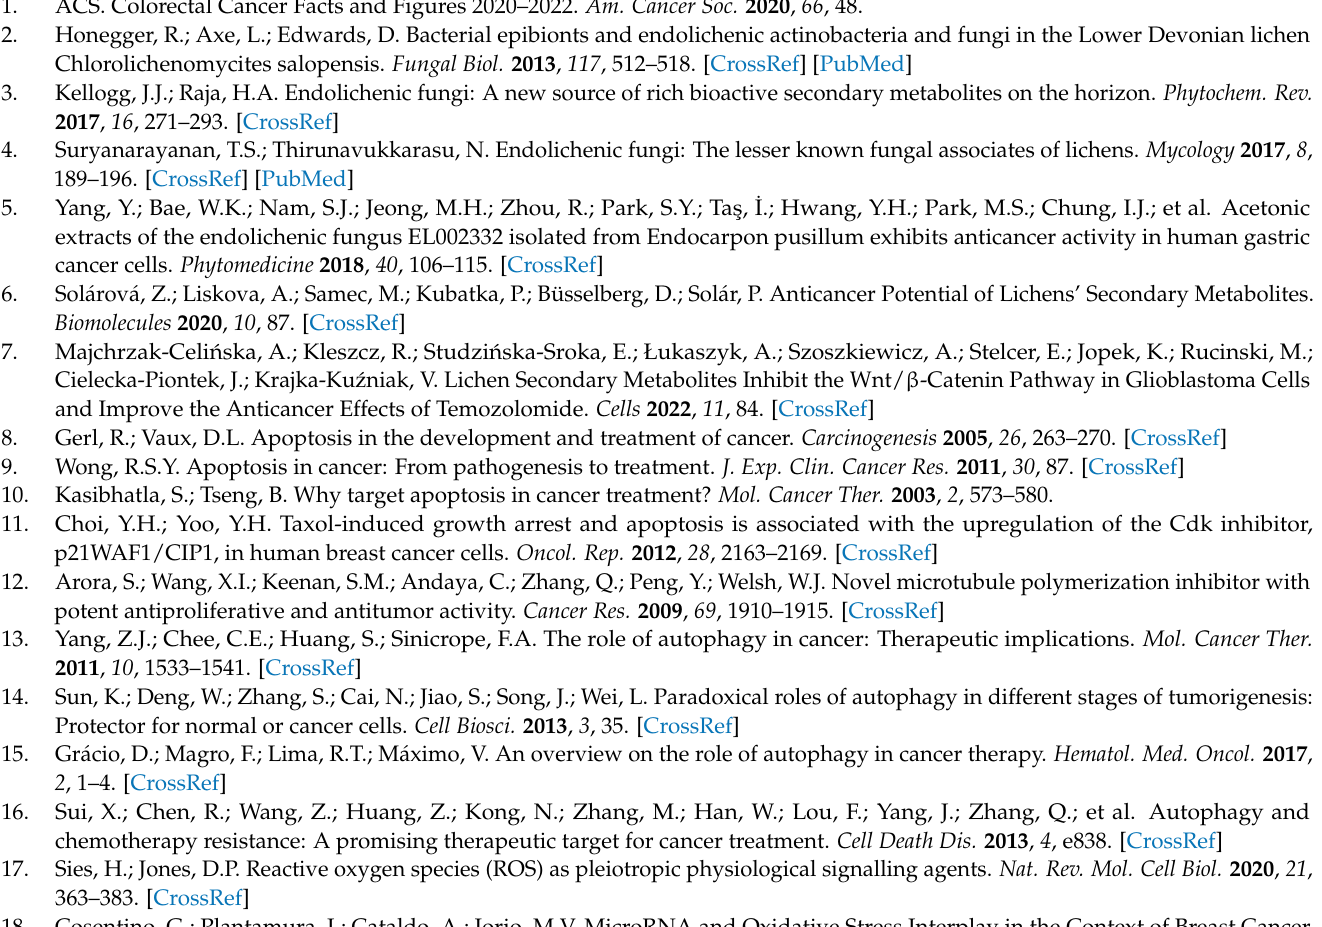
Figure S8: Percentage purity of Libertellenone T ( B ); Figure S9: The raw data of Western